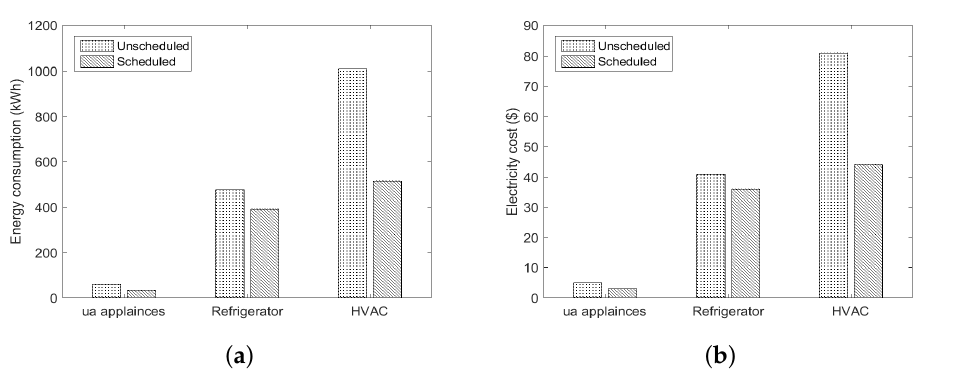
Figure 16. Comparison of total energy consumption and electricity cost of ua and tc appliances in unscheduled and scheduled cases: ( a ) energy consumption of ua and tc appliances; and ( b ) electricity cost of ua and tc appliances.